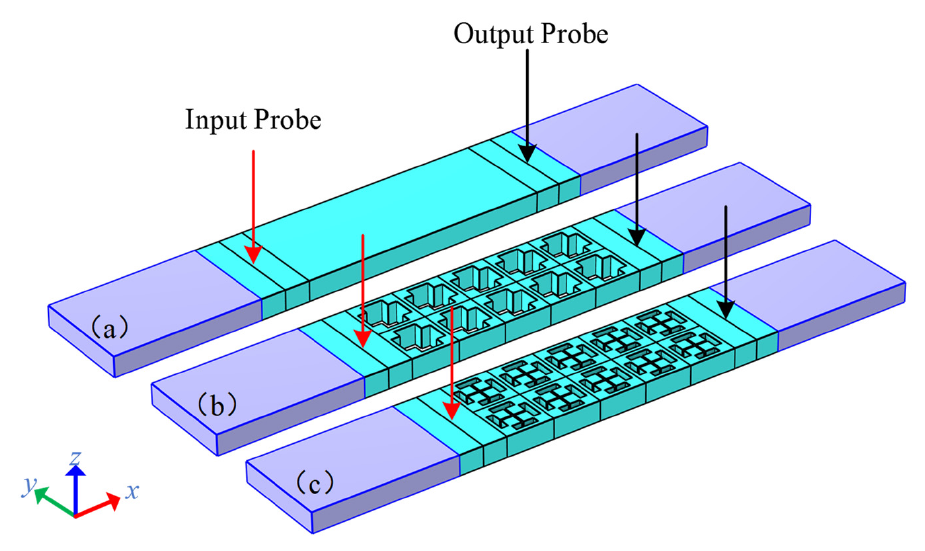
Figure 4. Delay line models: ( a ) solid versus delay line, ( b ) cross-like holey PnC structure versus delay line, and ( c ) DIH-PnC delay line. The deep areas at both ends are PML areas. The red arrows represent the input displacement excitation, and the black arrows represent the picked displacement results.